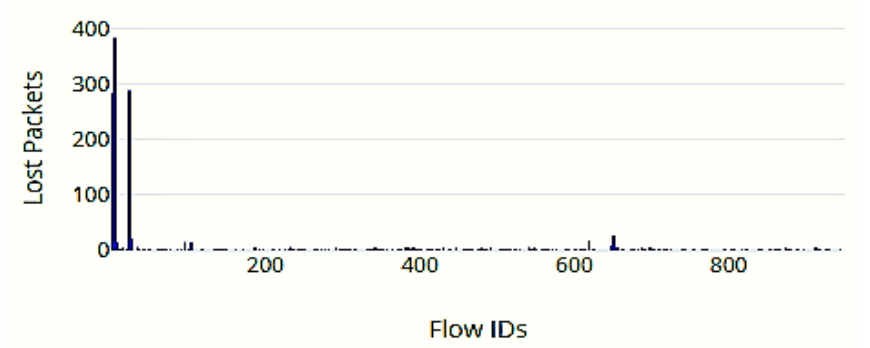
Figure 7. Number of packets